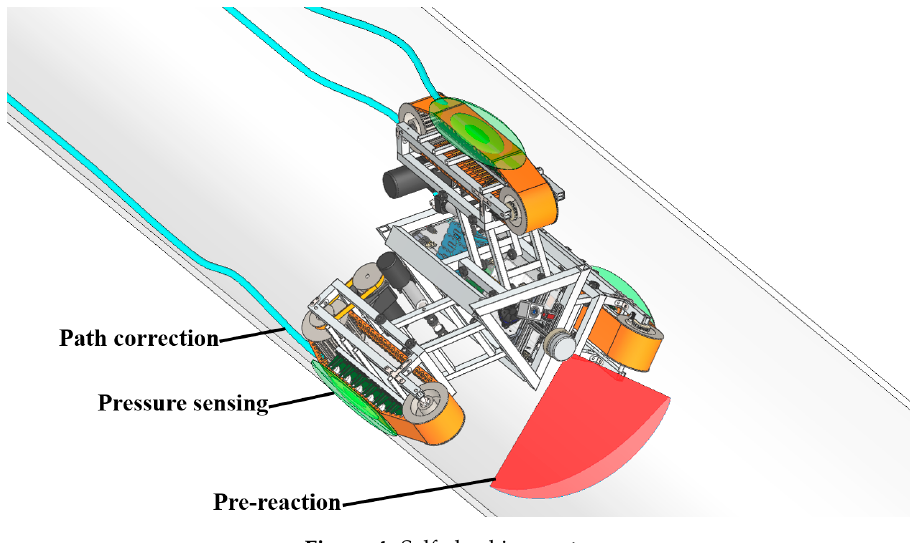
Figure 4. Self-checking system.